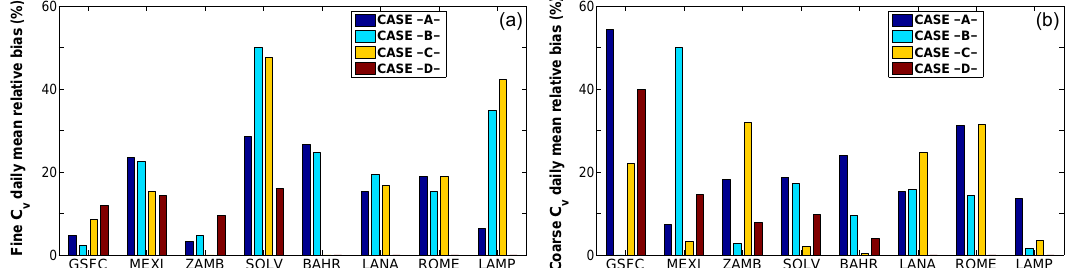
Figure 11. Relative differences between the daily averages of the volume concentrations retrieved by GRASP-AOD and AERONET standard inversions (total values can be found in Table 14) for the examples considered in the analysis as listed in Table 13. The differences for the fine mode are represented in the left panel and for the coarse mode in the right panel. Different days (A, B, C and possibly D) considered at each station and plotted with different colours.